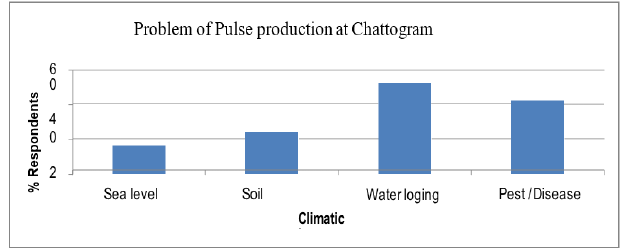
Figure 15: Farmers response on impacts of climate change on pulse